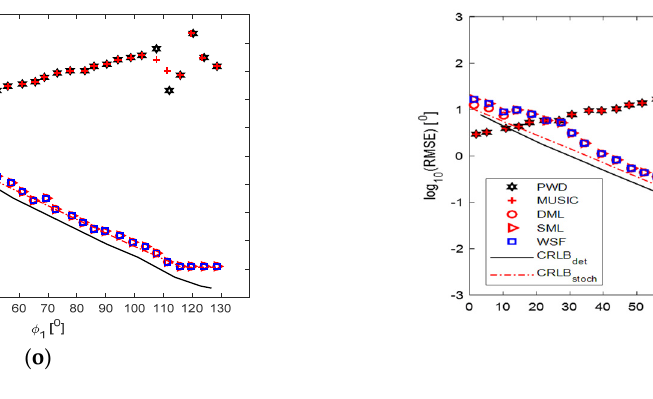
Figure 5. ( a )–( h ) RMSE over CRLB and 100 Monte Carlo samples when SNR = 20 dB for chosen Figure 5. ( a – h ) RMSE over CRLB and 100 Monte Carlo samples when SNR = 20 dB for chosen frequencies: ( a ) 𝜙(cid:3552) (cid:2869) ,𝑓 = 900 MHz ( b ) 𝜙(cid:3552) (cid:2870) , 𝑓 = 900 MHz ( c ) 𝜙(cid:3552) (cid:2869) , 𝑓 = 2 GHz ( d ) 𝜙(cid:3552) (cid:2870) ,𝑓 = 2 GHz frequencies: ( a ) ˆ φ 1 , f = 900 MHz ( b ) ˆ φ 2 , f = 900 MHz ( c ) ˆ φ 1 , f = 2 GHz ( d ) ˆ φ 2 , f = 2 GHz ( e ) 𝜙(cid:3552) (cid:2869) , 𝑓 = 4 GHz ( f ) 𝜙(cid:3552) (cid:2870) ,𝑓 = 4 GHz ( g ) 𝜙(cid:3552) (cid:2869) ,𝑓 = 8 GHz ( h ) 𝜙(cid:3552) (cid:2870) , 𝑓 = 8 GHz . ( i )–( p ) RMSE over CRLB and ( e ) ˆ φ 1 , f = 4 GHz ( f ) ˆ φ 2 , f = 4 GHz ( g ) ˆ φ 1 , f = 8 GHz ( h ) ˆ φ 2 , f = 8 GHz. ( i – p ) RMSE over 100 Monte Carlo samples when SNR = 20 dB for chosen frequencies: ( i ) 𝜙(cid:3552) (cid:2869) , 𝑓 = 16 GHz ( j ) 𝜙(cid:3552) (cid:2870) , 𝑓 = 16 GHz ( k ) 𝜙(cid:3552) (cid:2869) ,𝑓 = 32 GHz ( l ) 𝜙(cid:3552) (cid:2870) ,𝑓 = 32 GHz ( m ) 𝜙(cid:3552) (cid:2869) ,𝑓 = 40 GHz ( n ) 𝜙(cid:3552) (cid:2870) , 𝑓 = 40 GHz ( o ) 𝜙(cid:3552) (cid:2869) , 𝑓 = CRLB and 100 Monte Carlo samples when SNR = 20 dB for chosen frequencies: ( i ) ˆ φ 1 , f = 16 GHz 75 GHz ( p ) 𝜙(cid:3552) (cid:2870) , 𝑓 = 75 GHz . ( j ) ˆ φ 2 , f = 16 GHz ( k ) ˆ φ 1 , f = 32 GHz ( l ) ˆ φ 2 , f = 32 GHz ( m ) ˆ φ 1 , f = 40 GHz ( n ) ˆ φ 2 , f = 40 GHz ( o ) ˆ φ 1 , f = 75 GHz ( p ) ˆ φ 2 , f = 75 GHz.